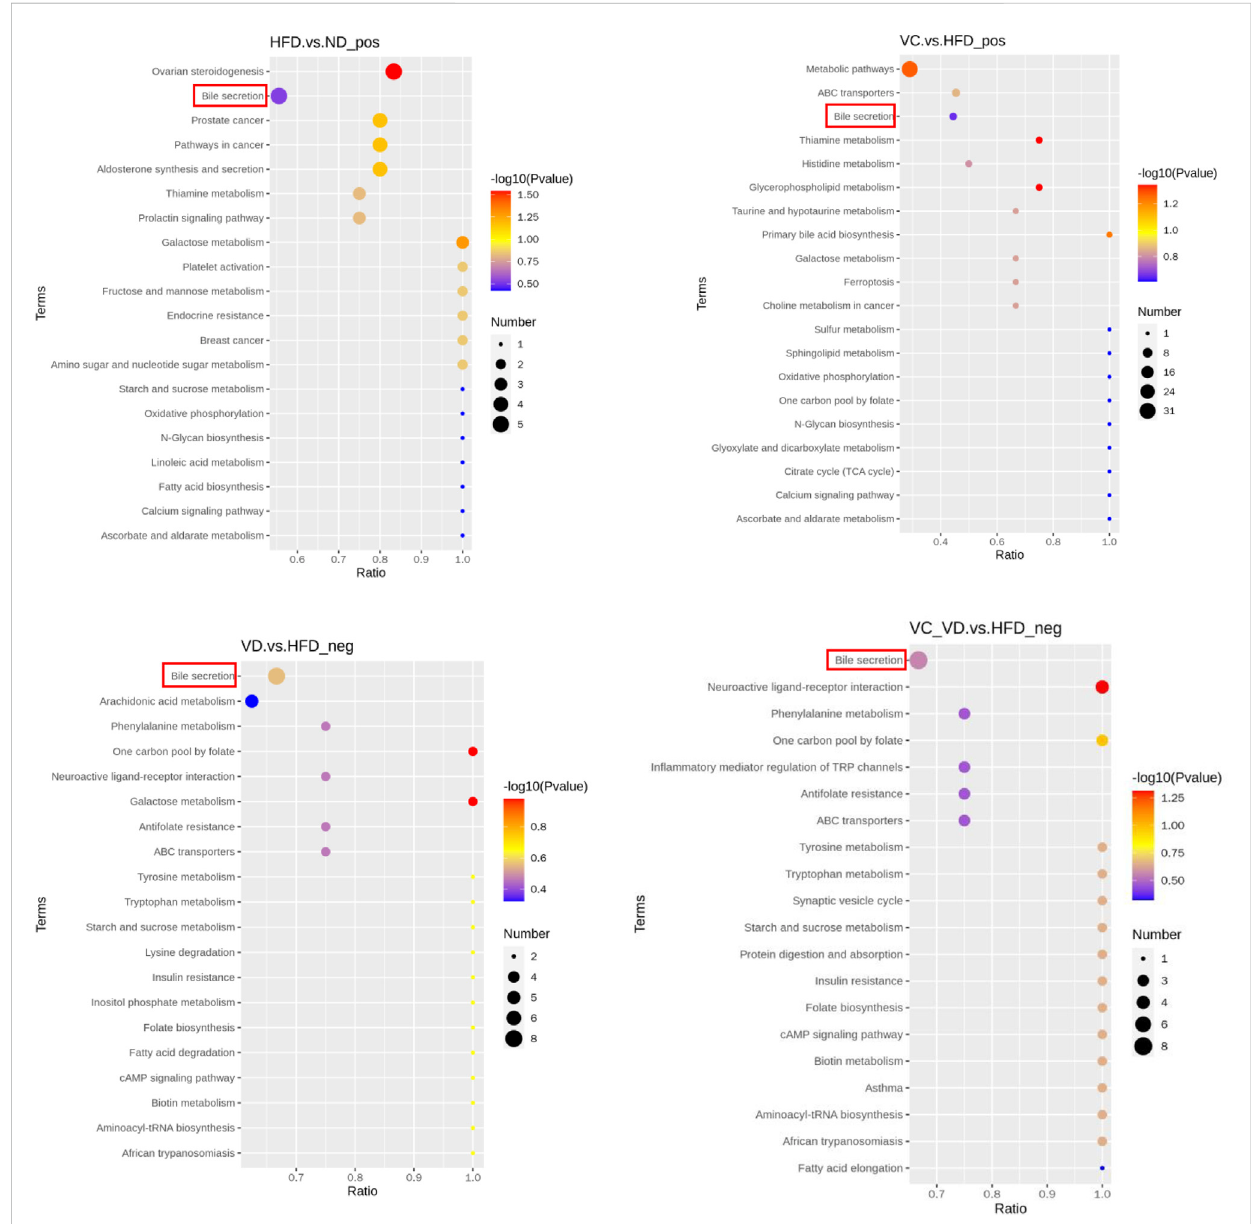
FIGURE 7 KEGG_Enrich.scatterplot. KEGG_Enrich.scatterplot (top 20) of the HFD vs. ND, VC vs. HFD, VD vs. HFD, and VC + VD vs. HFD groups; pos, positive polarity mode; neg, negative polarity mode. ( n = 12